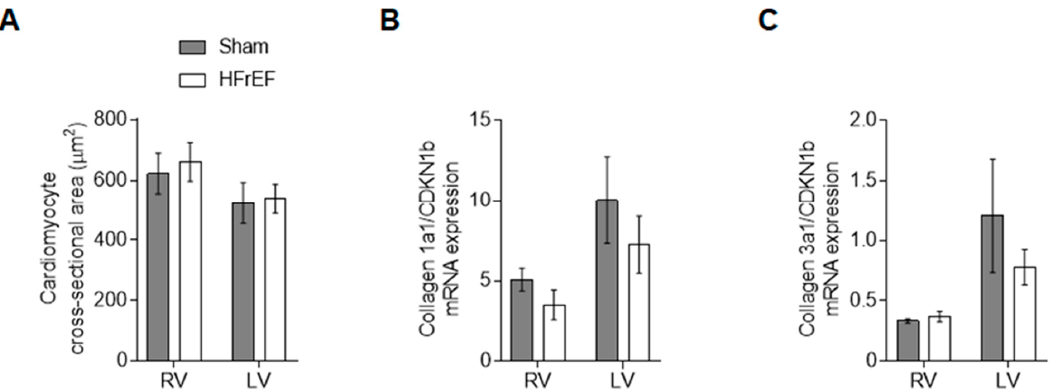
Figure 7. Homogenous ventricular structure in the post-ischemic rat heart. Cardiomyocyte size is given as cross-sectional area ( A ). RV and LV collagen 1a1 ( B ) and collagen 3a1 ( C ) mRNA expression relative to CDKN1b is shown. Data are shown as mean ± SEM; panel A: n = 16–27 cardiomyocyte/3–5 heart/group; panels B–C: mean ± SEM of 3 samples/group.